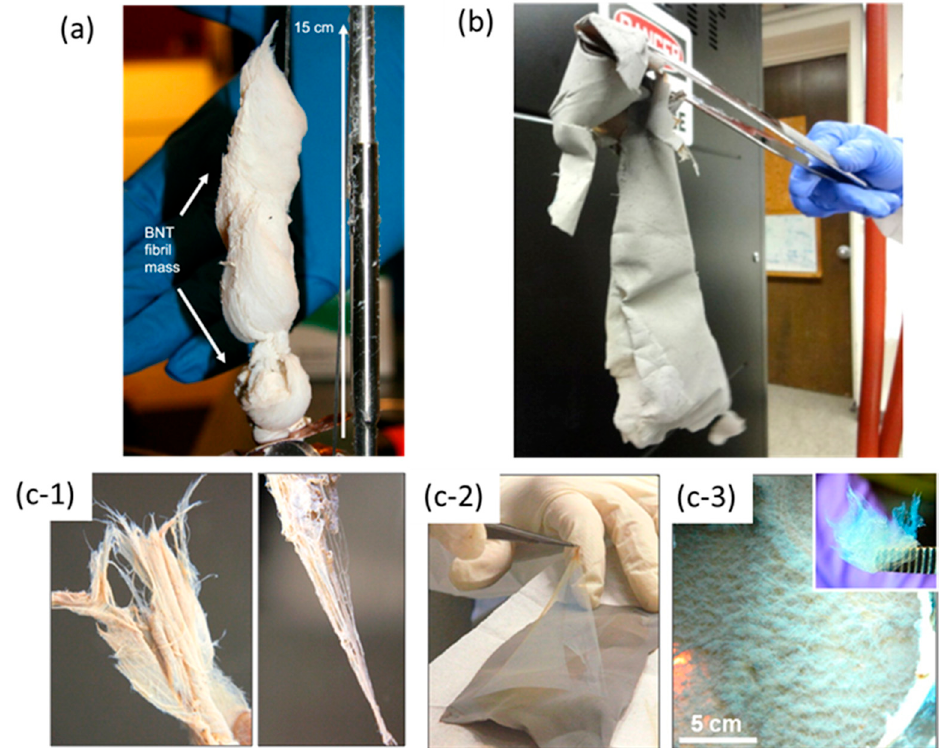
Figure 3. Macroscopic photographs of BNNTs produced by different techniques: ( a ) modified laser